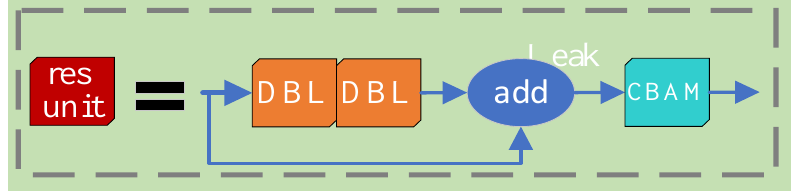
Figure 6. CBAM added to the residual unit .